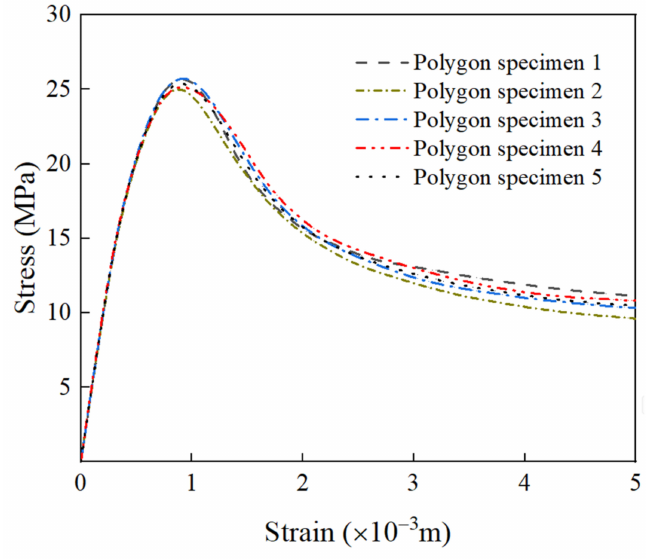
Figure 10. The stress–strain curve of random distribution of